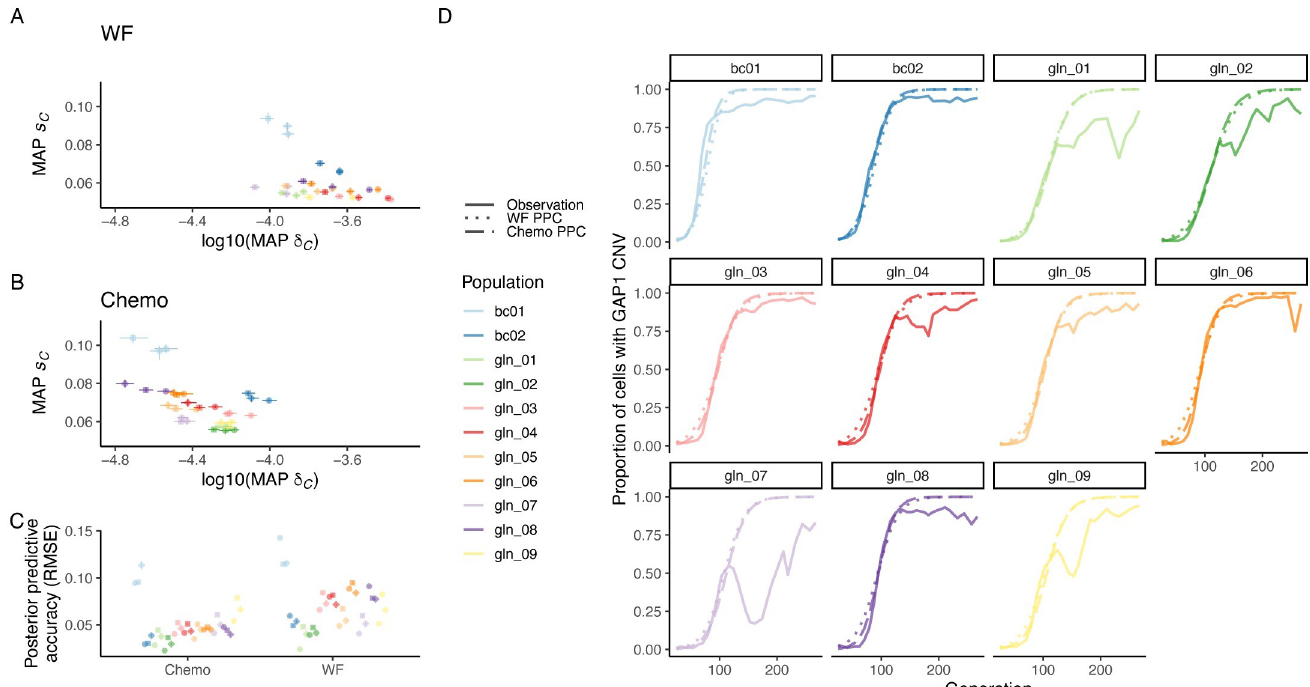
Fig 6. Inference of CNV formation rate and fitness effect from empirical evolutionary dynamics. The inferred MAP estimate and 95% HDIs for fitness effect s C and formation rate δ C , using the (A) WF or (B) chemostat (Chemo) model and NPE for each experimental population from [48]. Inference performed with data up to generation 116, and each training set (marker shape) corresponds to an independent amortized posterior distribution estimated with 100,000 simulations. (C) Mean and 95% confidence interval for RMSE of 50 posterior predictions compared to empirical observations up to generation 116. (D) Proportion of the population with a GAP1 CNV in the experimental observations (solid lines) and in posterior predictions using the MAP estimate from one of the training sets shown in panels A and B with either the WF (dotted line) or chemostat (dashed line) model. Formation rate and fitness effect of other beneficial mutations set to 10 − 5 and 10 − 3 , respectively. Data and code required to generate this figure can be found at https://doi.org/10.17605/OSF.IO/E9D5X. CNV, copy number variant; HDI, highest density interval; MAP, maximum a posteriori; NPE, Neural Posterior Estimation; RMSE, root mean square error; WF, Wright–Fisher.